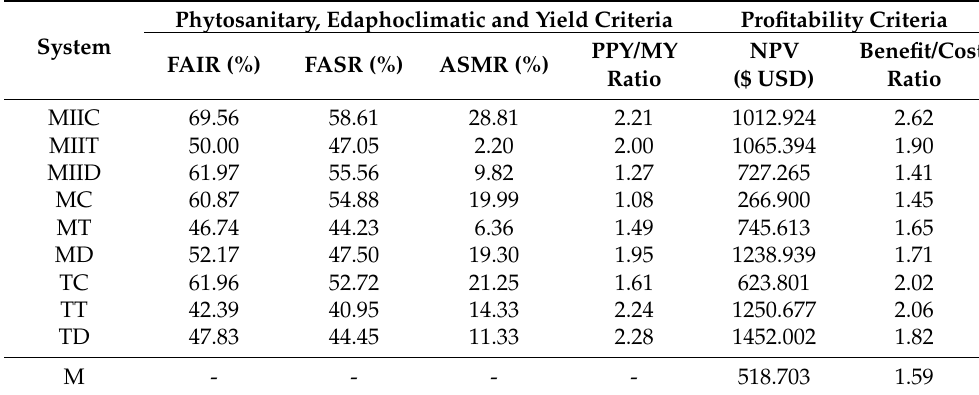
Table 3. Comparison of the performances of Push–Pull systems and maize monocultures. Phytosanitary, Edaphoclimatic and Yield System